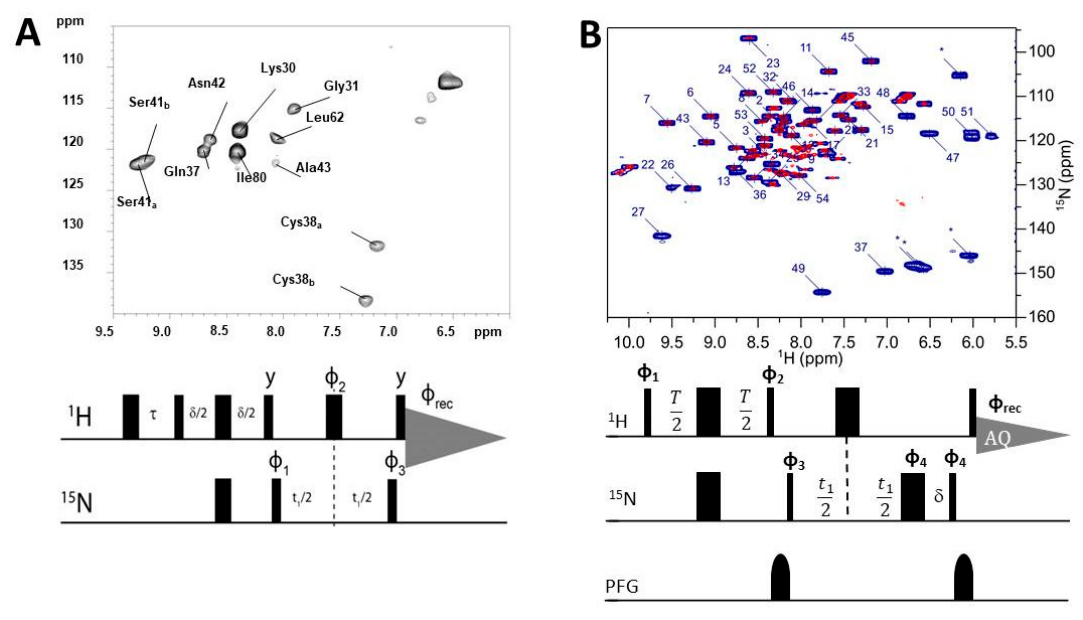
Figure 4. ( A ) Lower part: Pulse scheme of IR- 15 N-HSQC-AP experiment. Phases as follows: φ 1 = (x, − x), φ 2 = (x,x, − x, − x), φ 3 = (x,x,x,x, − x, − x, − x, − x), φ rec = (x, − x,x, − x, − x,x, − x,x). When undefined, phase x is used. Upper part: the IR-HSQC-AP spectrum of 1 mM holo-GLRX5 at 800 MHz is displayed reporting the paramagnetic NH signals and their assignment. The residues having two sets of signals in holo-GLRX5 are indicated with labels a and b. ( B ). Lower part: Pulse scheme of 1 H R 2 -weighted 15 N HSQC-AP experiment. Phases as follows: φ 1 = x, − x,y, − y; φ 2 = 2(y),2(x); φ 3 = 2(x), 2( − x); φ 4 = 4(x),4( − x); φ rec = x, − x, − x,x, − x,x,x, − x. When undefined, phase x is used. Upper part: 15 N HSQC spectra of PioC obtained with an R 2 -weighted 15 N-HSQC-AP experiment (blue) vs. the first point of the R 2 series collected with the standard experiment (red). Experiments were recorded using a 500 MHz. Folded peaks are marked with an asterisk. Figure adapted from References [75,88,96].